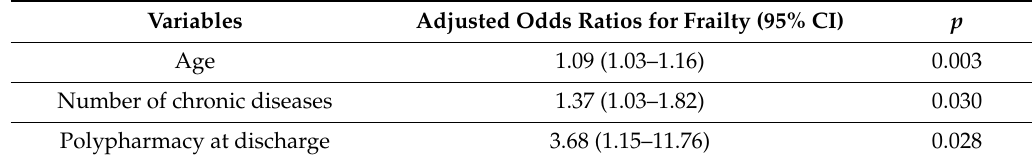
Table 3. Predictive factors for transition to frailty in multivariable logistic regression.